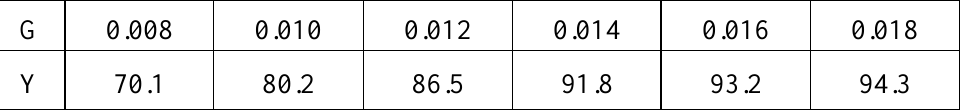
Table 3. Influence of the catalyst level (G) on